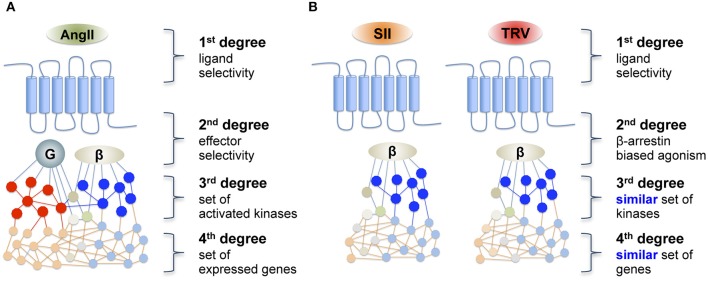
Schematic representation of (A) a reference agonist and (B) the hypothesis of downstream transduction of a “biased message” after receptor activation by a biased agonist. AngII, angiotensin II; SII, [Sar1, Ile4, Ile8]-AngII; TRV, TRV027 ([Sar1, D-Ala8]-AngII).